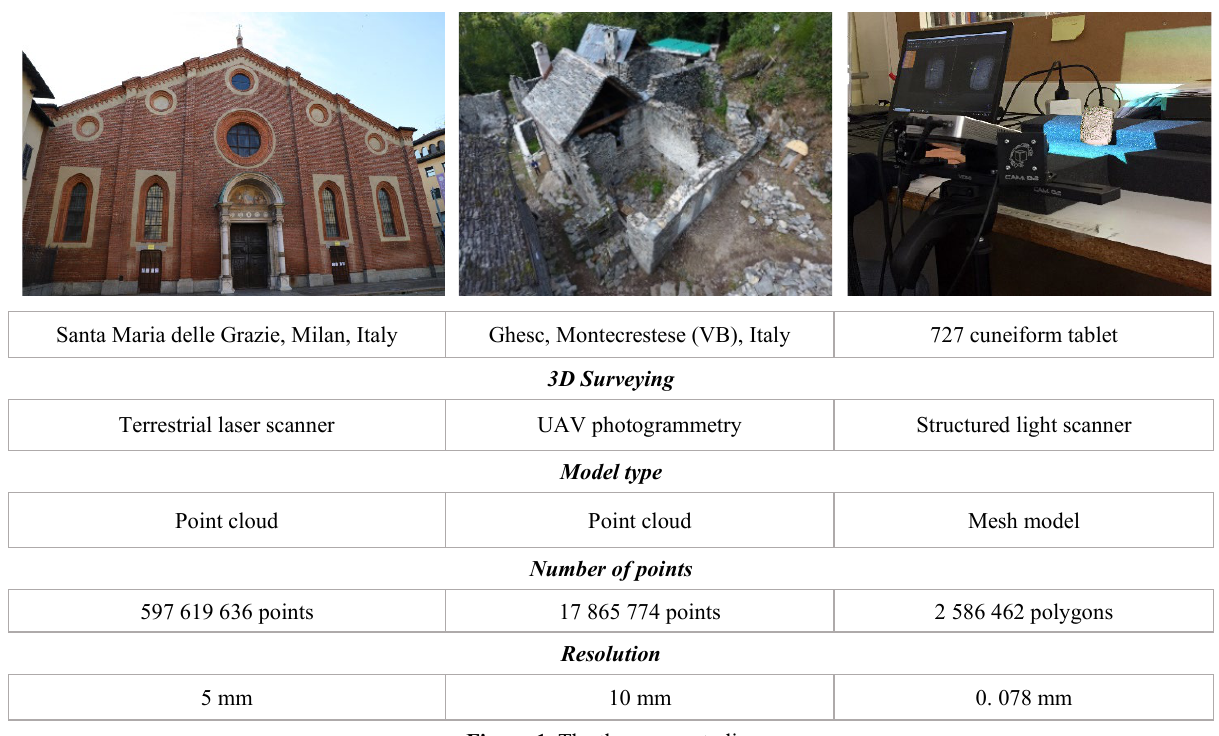
Figure 1. The three case